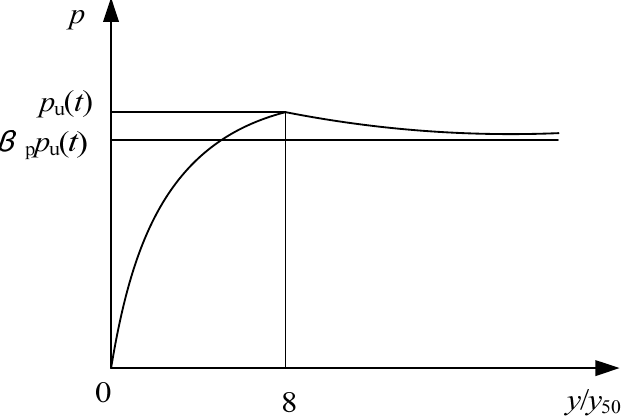
Figure 2. The p ‐ y curve in consideration of time ‐ varying characteristics. Figure 2. The p - y curve in consideration of time-varying